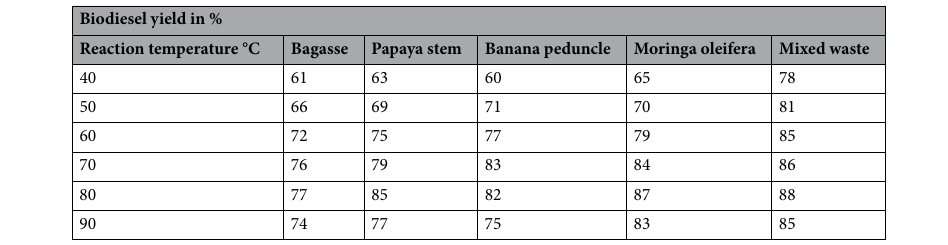
Table 2. Reaction temperature effects in biodiesel yield.